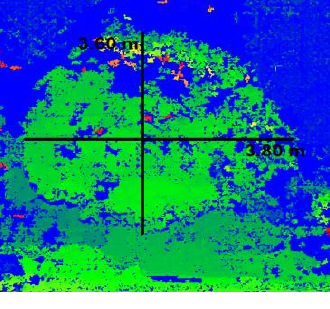
Figure 11. Crown